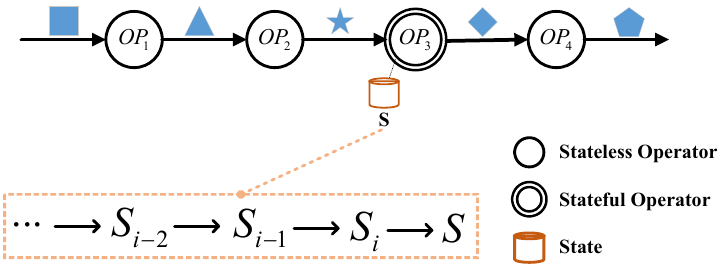
Figure 3. One DSP dataflow instance, which consists of four operators. OP3 is a stateful operator with state S, recursively traced back to the previous state.